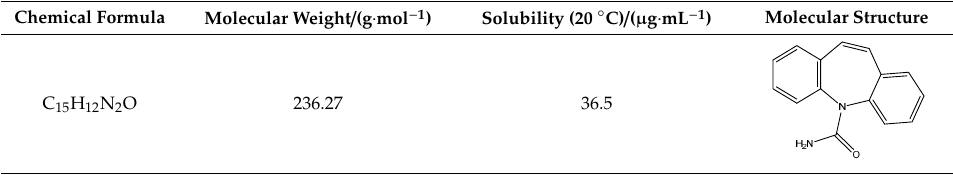
Table 1. Molecular structure and solubility of carbamazepine (CBZ).